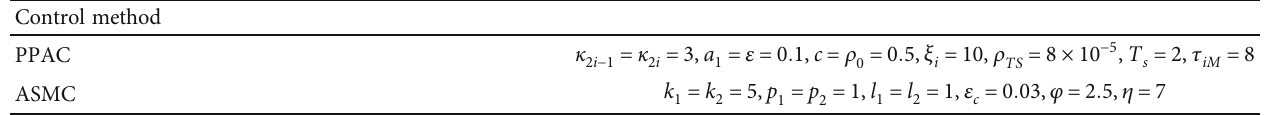
Figure 5: The algorithm fl ow chart. Table 3: The control parameter con fi